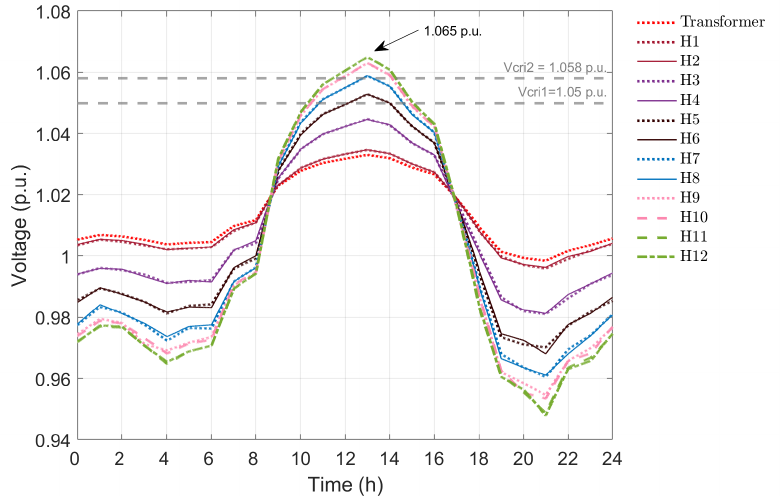
Figure 7. Voltage profile of twelve houses (House 1 to House 12) in the base